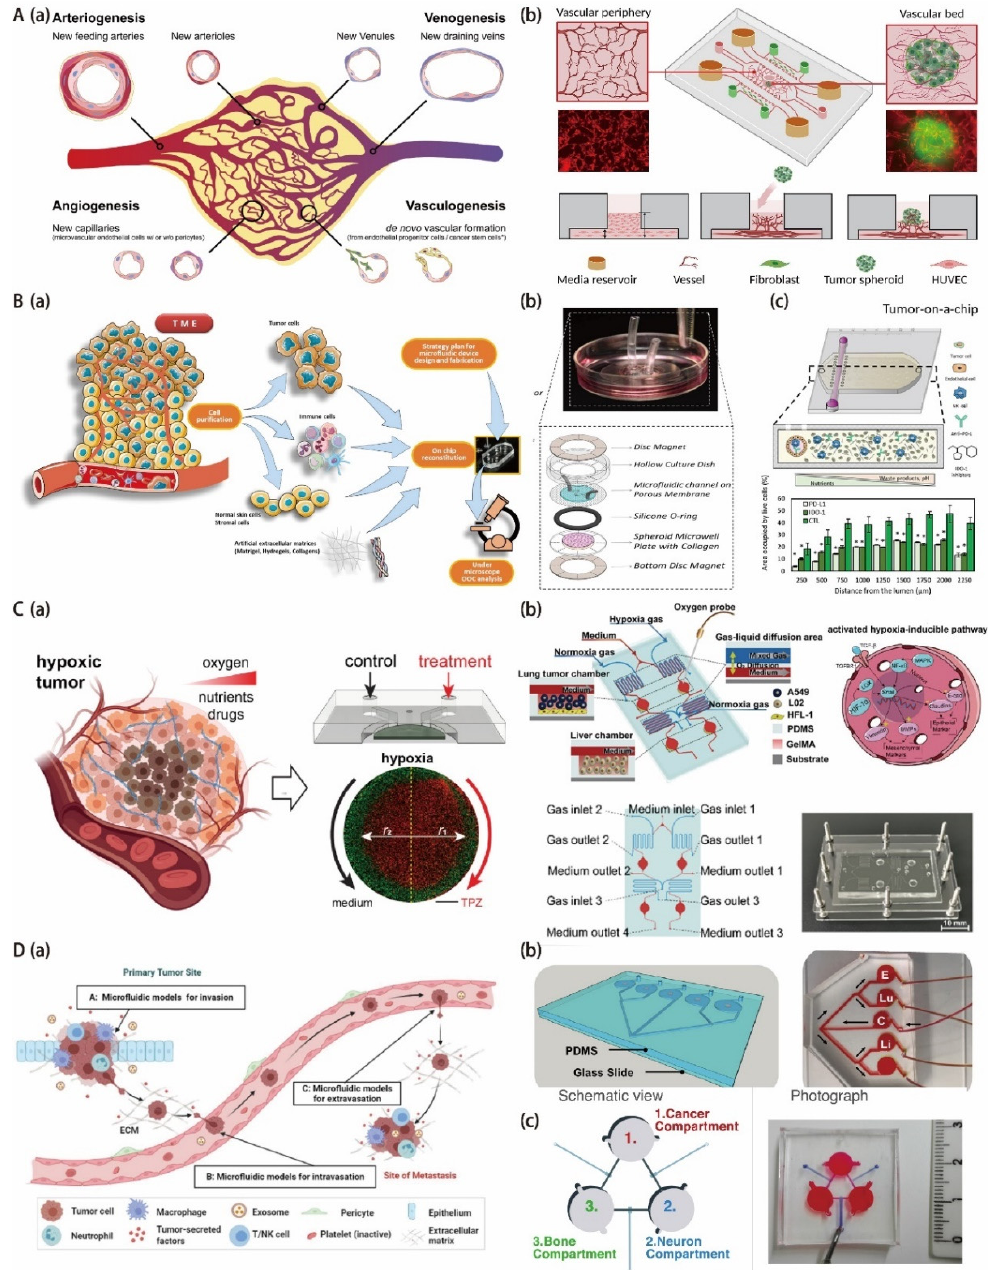
Figure 4. ( A ) Vascularized tumor chips. ( a ) The combination of angiogenesis and vasculogenesis represents the fundamental processes of new blood vessel formation. The newly formed blood vessels can provide nutrients and oxygen for malignant tumor development and metabolic waste re- moval. Moreover, they are able to have interactions with various types of cells in the vascular niche. The figure shows the processes of different blood vessel formations, including neoarteriogenesis, vascular remodeling, venogenesis, and angiogenesis. Adapted with permission from Ref. [110]. Copyright 2019, MDPI. ( b ) Schematic of the vascularized tumor spheroid-on-a-chip. The device con- sists of 5 microchannels in parallel by implanting HUVECs in fibrin gel into the chip (day 0) for self- assembling a vascular network (day 5), wherein tumor spheroids are placed and integrated with the surrounding blood vessels (day 15) to achieve tumor vascularization. Adapted with permission from Ref. [129]. Copyright 2022, ACS. ( B ) Onco-immuno chips. ( a ) Schematic representation of the reconstituted immuno-TME on OoC models. Adapted with permission from Ref. [138]. Copyright 2021, Frontiers. ( b ) Realization of TIME-on-a-chip on a 35 mm Petri dish platform: a ring magnet is used, microfluidic channels printed on a porous membrane are attached to a modified Petri dish